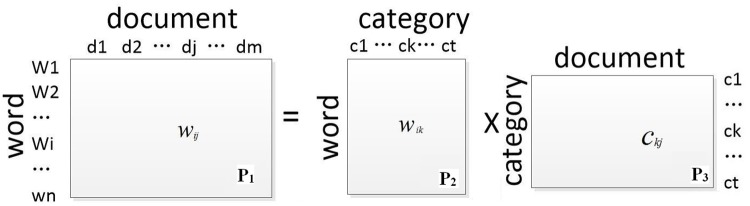
Words mapping with Wikipedia.